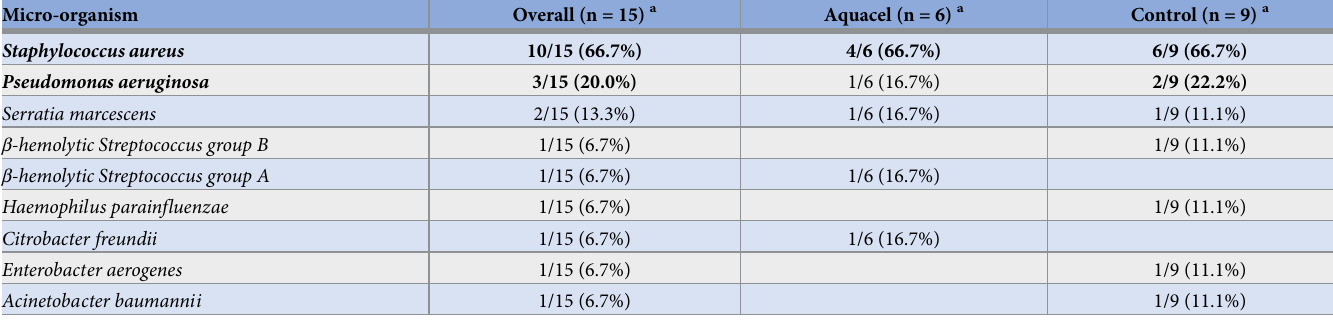
Table 3. Microbiological culture results of SSI